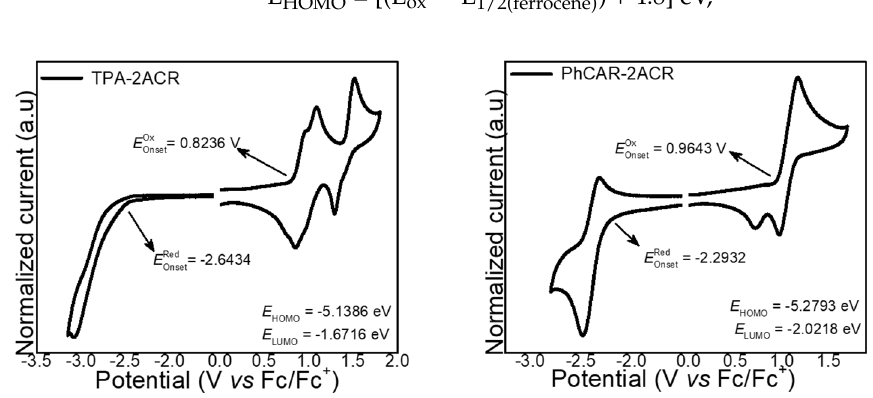
Figure 4. Cyclic voltammetry measurements of TPA ‐ 2ACR and PhCAR ‐ 2ACR.